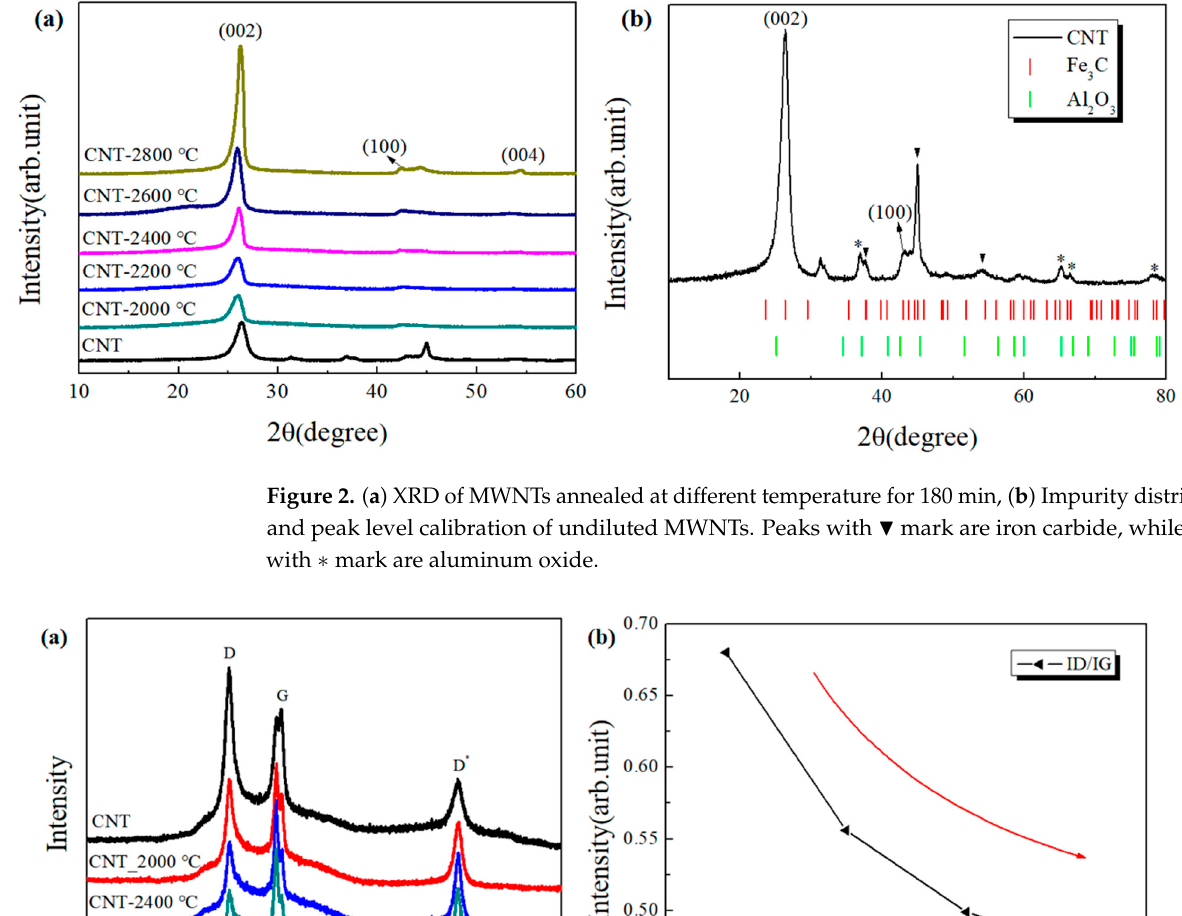
Figure 2. ( a ) XRD of MWNTs annealed at different temperature for 180 min, ( b ) Impurity distribu- tion and peak level calibration of undiluted MWNTs. Peaks with ▼ mark are iron carbide, while peaks with ∗ mark are aluminum oxide.